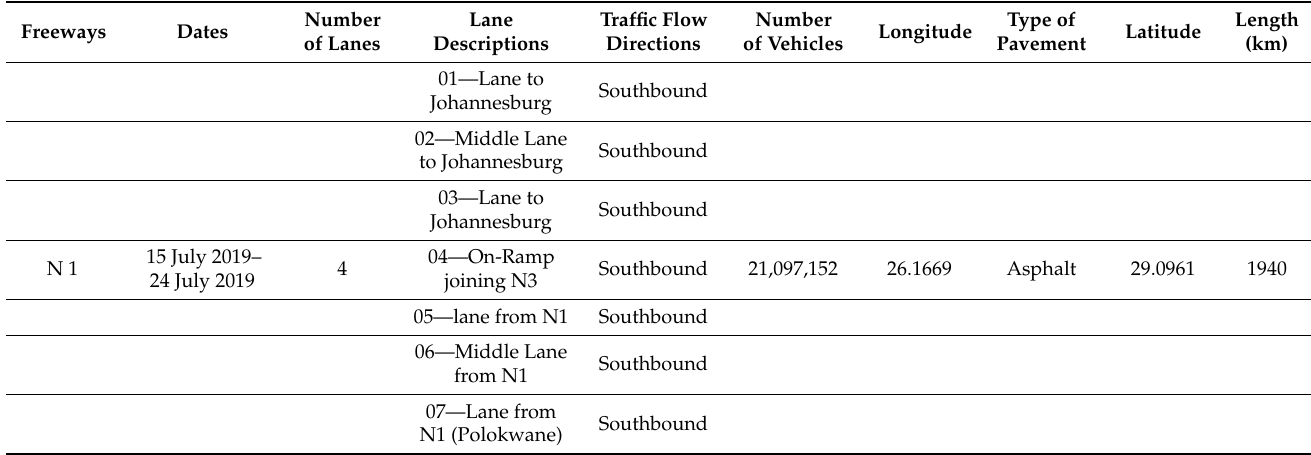
Table A1. Characteristics of the Five